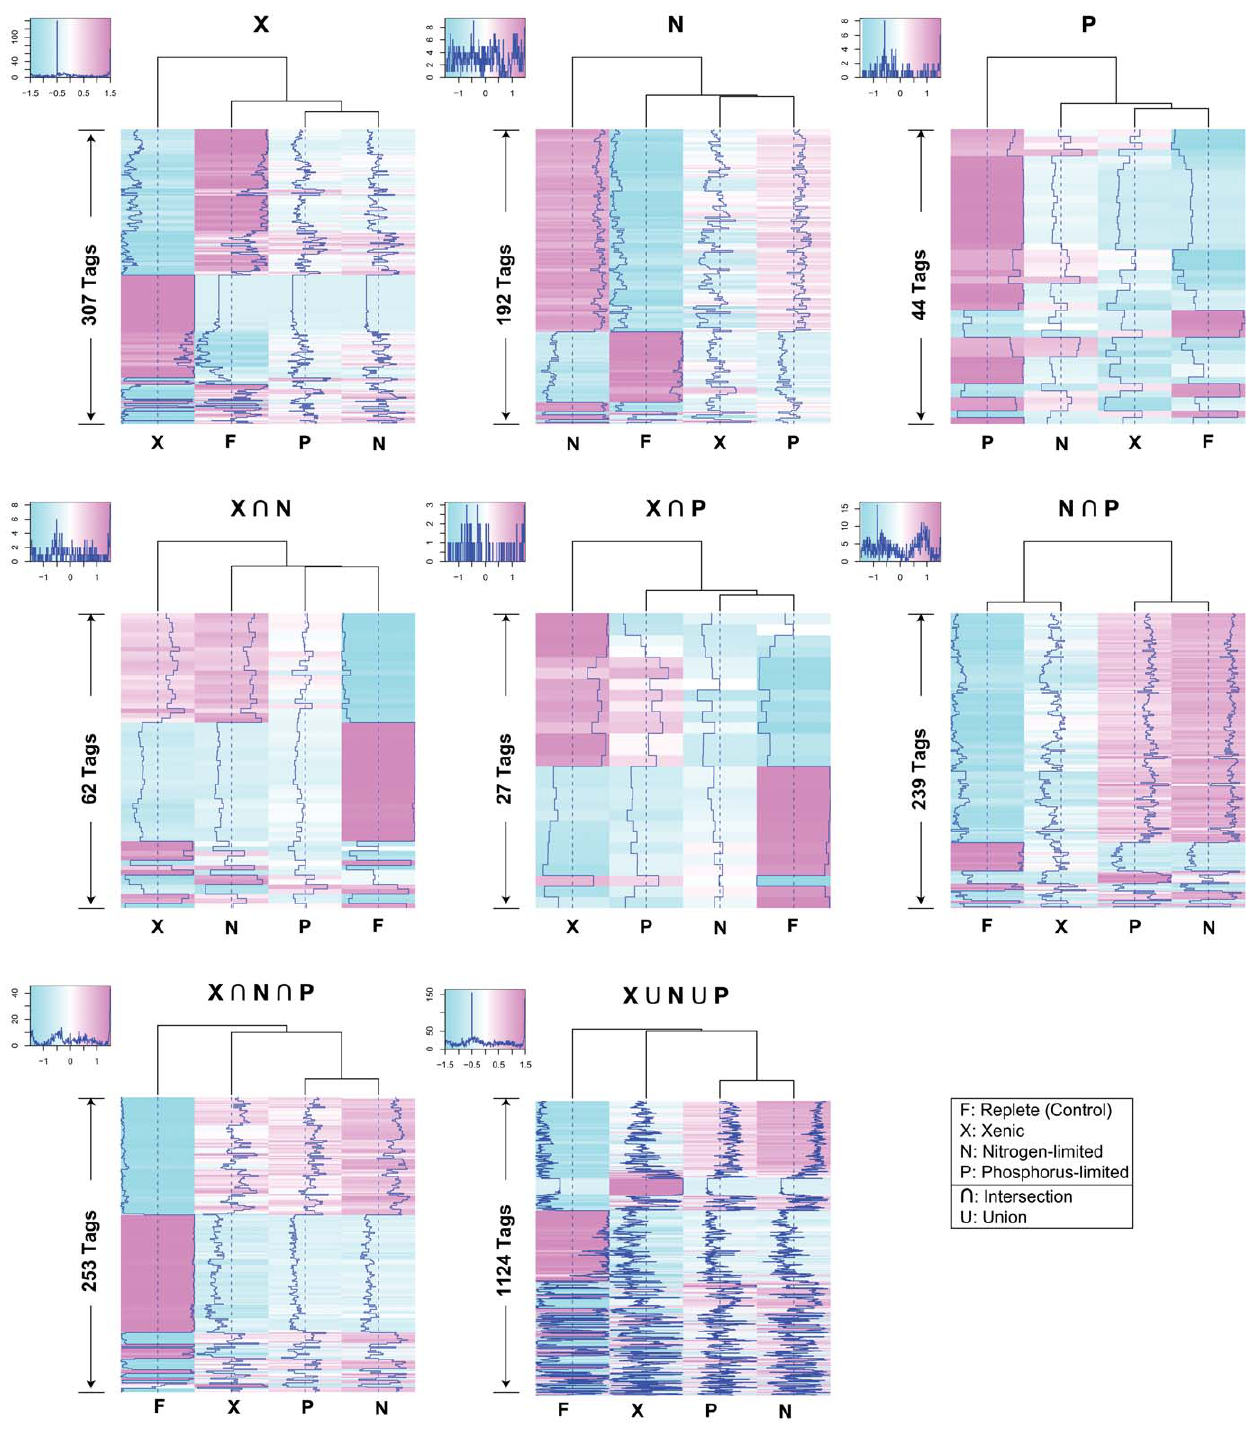
Figure 3. Differentially expressed signatures in response to three different culture treatments when compared to the control. Heatmap of the differentially expressed signatures under the three treatments (N, P, and X) compared to the control (F). The intersection between the treatments indicates signatures that showed significant differential expression patterns in two conditions out of the three or in the three conditions compared to the control. doi:10.1371/journal.pone.0009688.g003 Transketolase plays an important role in cellular metabolism signatures that match three different ESTs that encode light- through the catalysis of two opposing reactions in the pentose harvesting chlorophyll binding proteins. In addition, a transcript phosphate pathway, the primary source for nicotinamide adenine encoding a transketolase (EC 2.2.1.1) was down regulated by a dinucleotide phosphate (NADPH) and five-carbon sugars, the fold-change ratio of 2.5 (173/31) and a p-value of 3.24E-23.